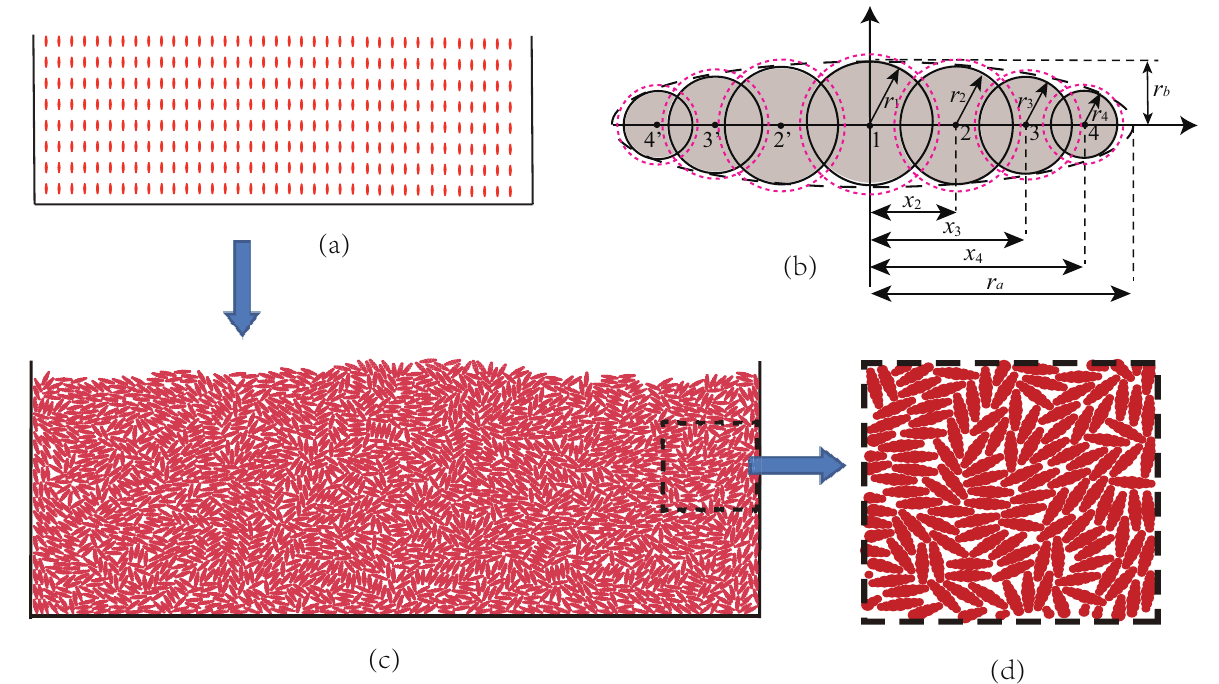
Figure 5. Result of the dense accumulation problem of 3000 elliptical particles using the ICA. ( a ) Initial state; ( b ) sketch of the Glued Particle Method (GPM) for an elliptical particle, where the gray profile is the real radius and the red dashed profiles are the imaginary coats; ( c ) final result of dense accumulation; and ( d ) some details of sub-figure ( c